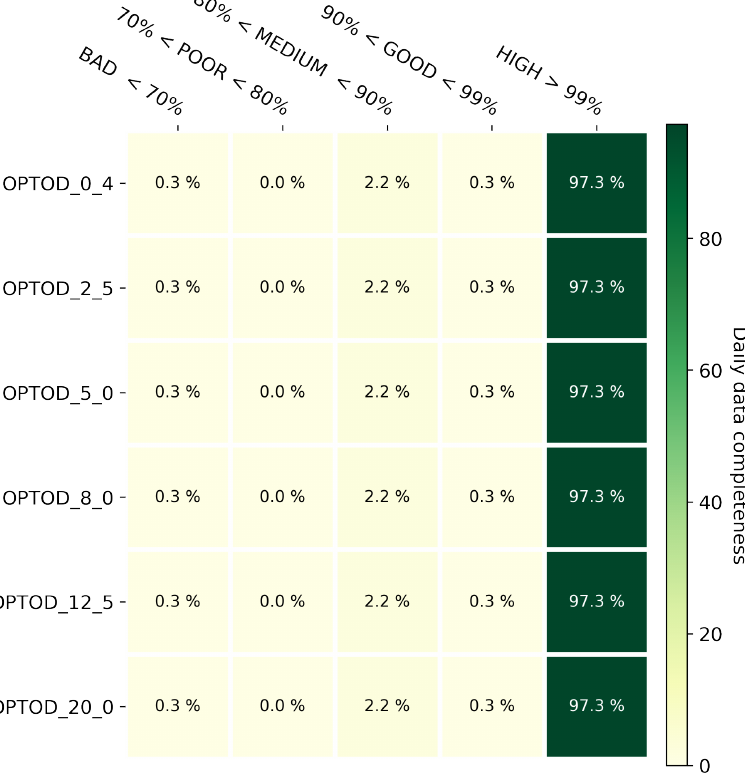
Figure 11. Daily data completeness heatmap based on the classification of the daily percent value of completeness in five FL classes: bad, poor, good, and